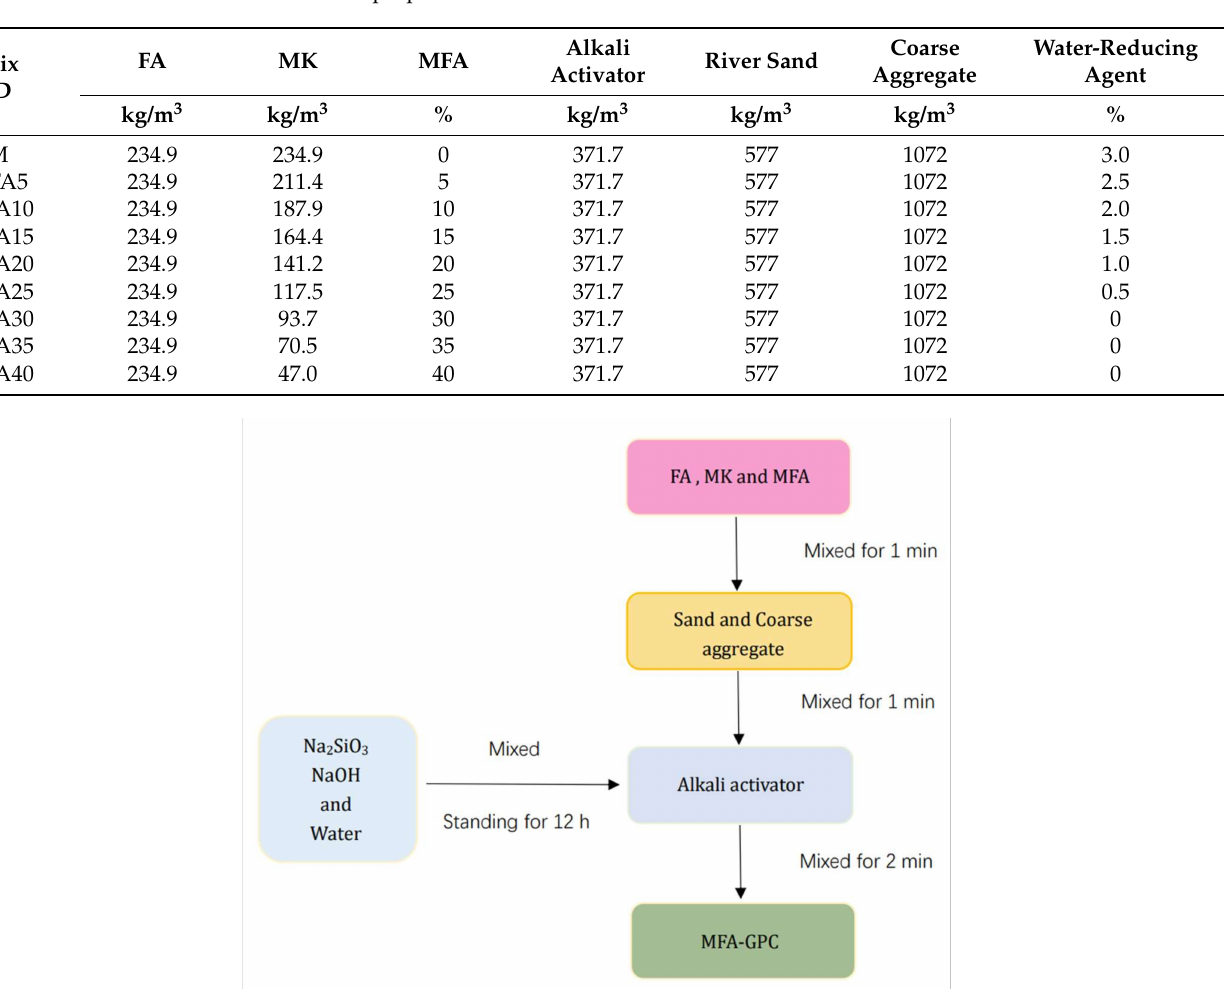
Table 3. Mix proportions of MFA-GPC.